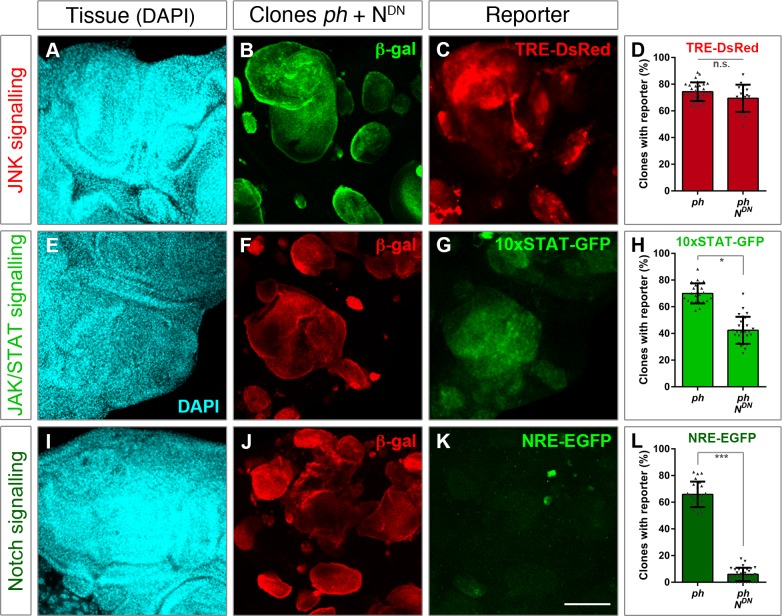
Impairment of Notch signalling has little effect on JNK and JAK/STAT.Upon impaired signal transduction of the Notch pathway, by expressing UAS-NDN in ph clones, the effects were assessed using reporters for JNK signalling (TRE-DsRed) (A-D) the JAK/STAT pathway (10xSTAT-GFP) (E-H) and NRE-EGFP for Notch (I-L). The proportion of clones with expression of the Notch reporter was markedly reduced in comparison to ph clones alone (L), serving as a positive control. The JNK reporter was similarly expressed in both conditions (D), and a mild reduction of the JAK/STAT reporter (G) was observed. DAPI staining is shown to depict tissue morphology (left panels), mutant clones are marked by β-gal expression in green (B) or red (F,J) with the remaining channel for respective signalling reporters (C,G,K). The average percentage of clones showing reporter expression was measured both in ph clones alone and upon expression of NDN, as shown in the bar plots (D,H,L). The error bars represent standard deviation; *** p<0.005, * p<0.01 (Student t-test). Scale bar represents 100 μm.